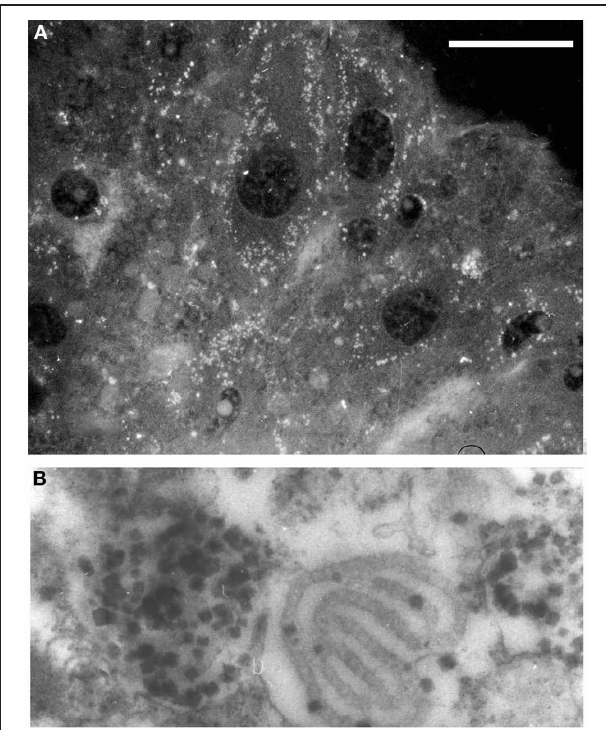
FIGURE 3 | (A) AChE reaction is localized in membranous granules at the periphery of the egg cell. (B) Higher magnification of the cortical layer, corresponding to the rectangular area in A . The arrows point to some of the positive granules. (C) TEM image of the same granules. The AChE reaction (dark staining) is reduced to the surface of the fertilization cone after fertilization. (D,E,F) The arrows show the point of sperm entry. Bars equal 50 μ m. f, fertilization